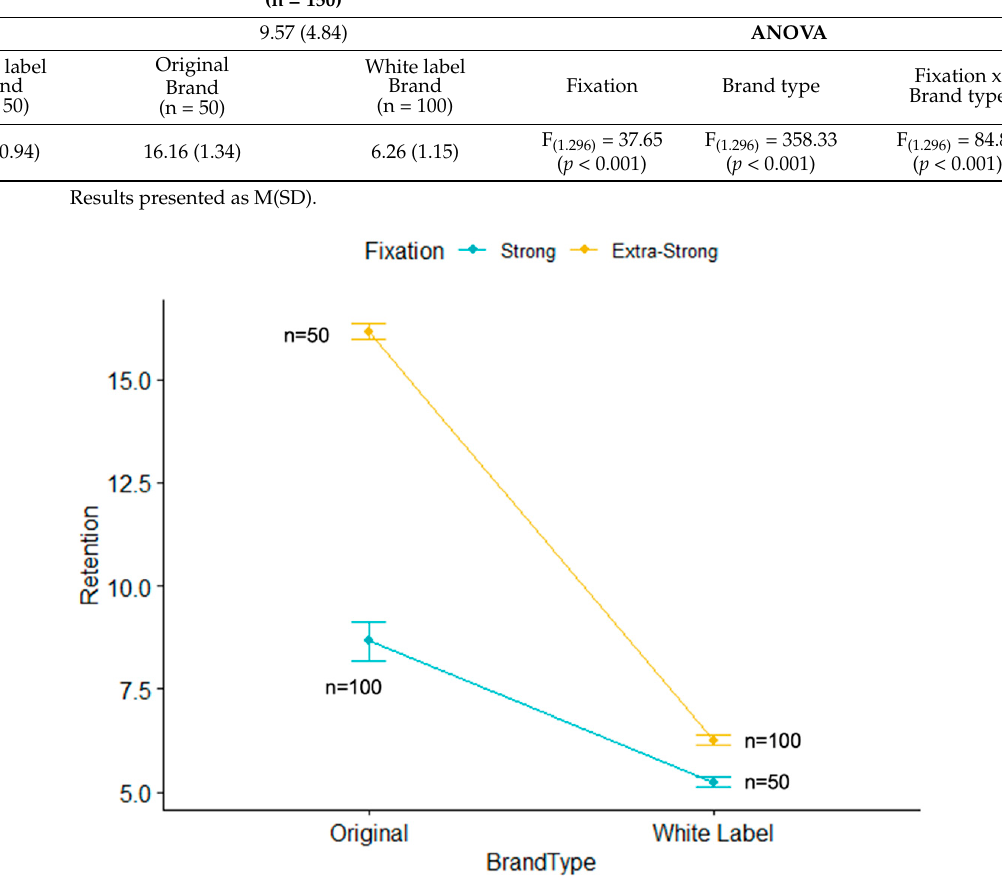
Figure 8. Interaction of the type of fixation with the type of brand.